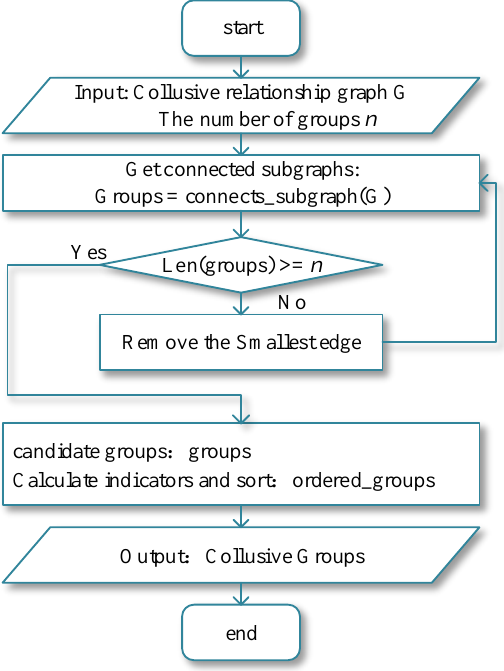
Figure 3. Collusive Groups Detection Flowchart